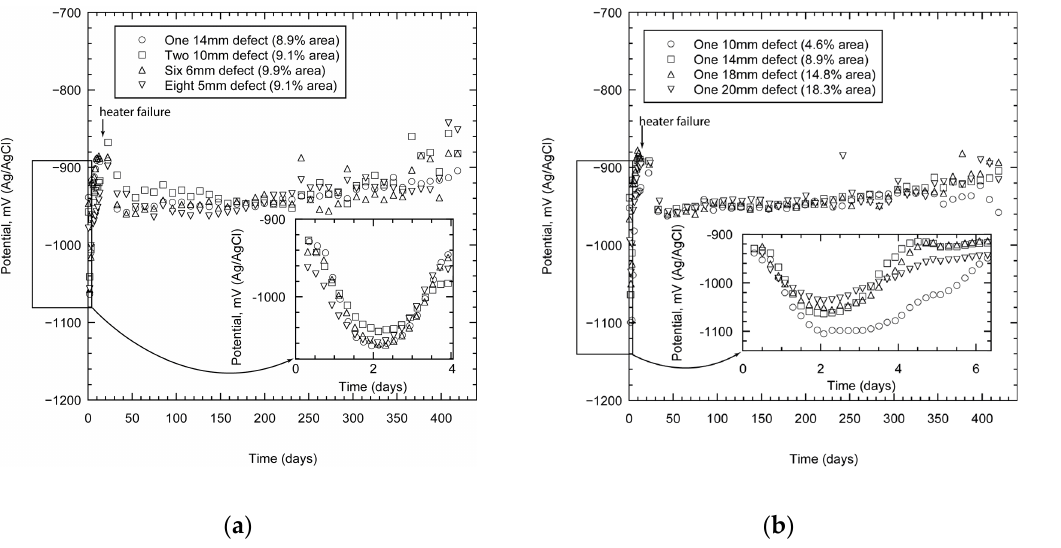
Figure 3. Measured open circuit potential (OCP) of TSA specimens showing the effect of damage size ( a ) , and distribution ( b ). The measurements were carried out in synthetic seawater (ASTM D1141) at 25 °C.